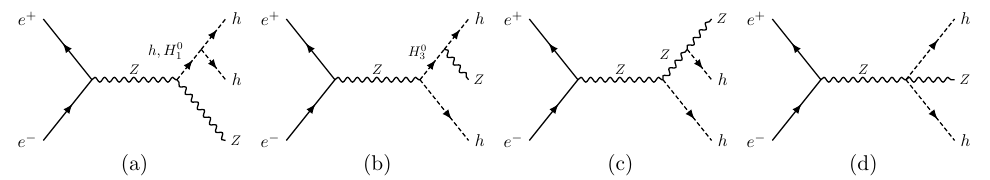
Figure 14 . Feynman diagrams for hhZ production at e + e